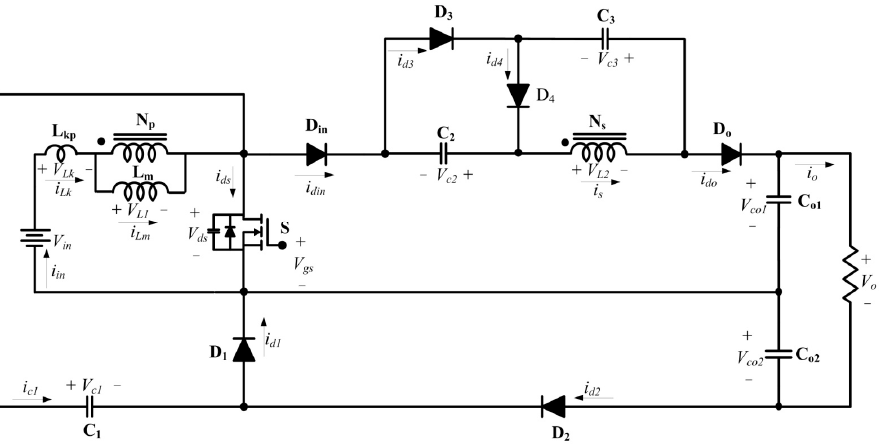
Figure 1. Circuit configuration of the proposed converter.